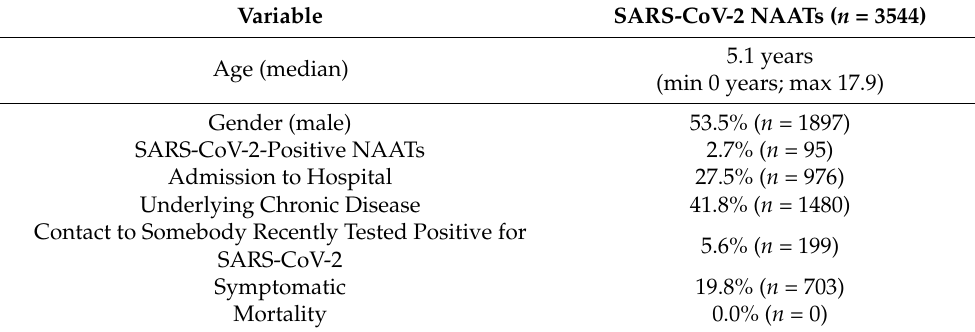
Table 1. Demographic data on SARS-CoV-2 NAATs ( n = 3544).